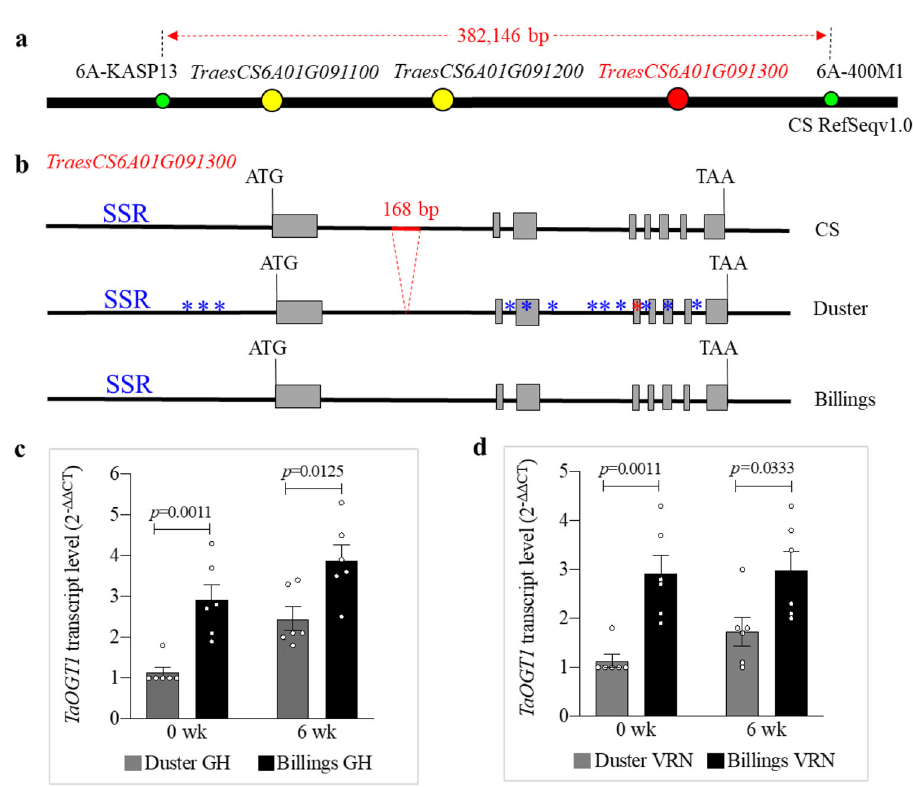
Fig. 2 Physical location and identi fi cation of QHd.osu-6A candidate gene. a The physical locations of QHd.osu-6A candidate genes. The QHd.osu-6A interval is delimited within 382,146 bp, fl anked by the two markers 6A-KASP13 and 6A-400M1 that are indicated in green dots. The candidate gene, TraesCS6A01G091300 , is indicated in a red dot, and the other two candidate genes in this region are indicated in yellow dots. b Allelic variation in TraesCS6A01G091300 among Chinese Spring (CS), Duster, and Billings. The sequence of TraesCS6A01G091300 in Billings is the same as in CS, but the sequence of Duster has SNPs across the gene, which are indicated with blue asterisks. A red asterisk indicates a SNP that changes amino acid. SSR denotes simple sequence repeats in the promoter region of TraesCS6A01G091300 . The region of 168-bp insertion in intron 1 of the Billings allele is indicated by a red line. c , d Comparison of transcript levels of TraesCS6A01G091300 alleles in Duster and Billings in non-vernalized (GH) and vernalized plants (VRN) at two different stages. The RNA samples were collected from fully developed leaves at the fourth-leaf stage (0 wk) and after vernalization for 6 weeks (6 wk). Transcript levels of TraesCS6A01G091300 were analyzed using qRT-PCR and calculated using the 2 – ΔΔ CT method, where CT is the threshold cycle. The mean transcript level for each allele was analyzed using three biological replicates and two technical replicates, and a two-tailed unpaired Students ’ t test showed no signi fi cant difference in expression between the two alleles ( n = 6). The bars indicate standard error. Source data underlying ( c , d ) are provided as a Source Data fi